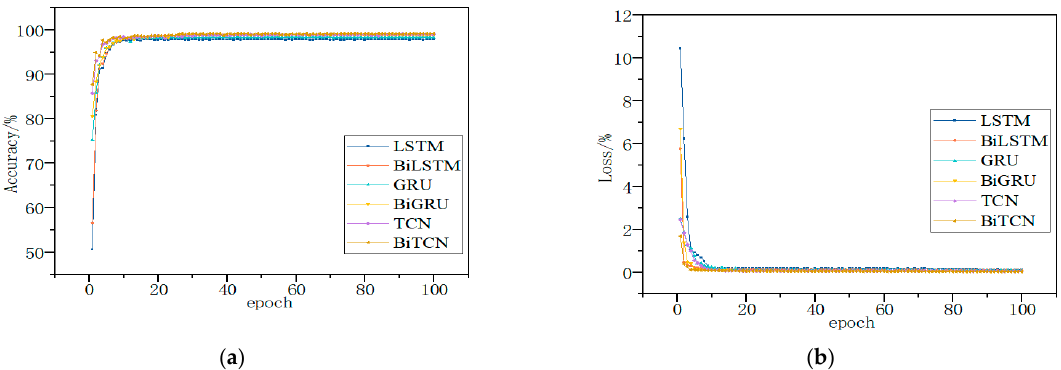
Figure 13. The Evaluation Results Based on Kaggle Dataset; they should be listed as: ( a ) Description of accuracy; ( b ) Description of loss.